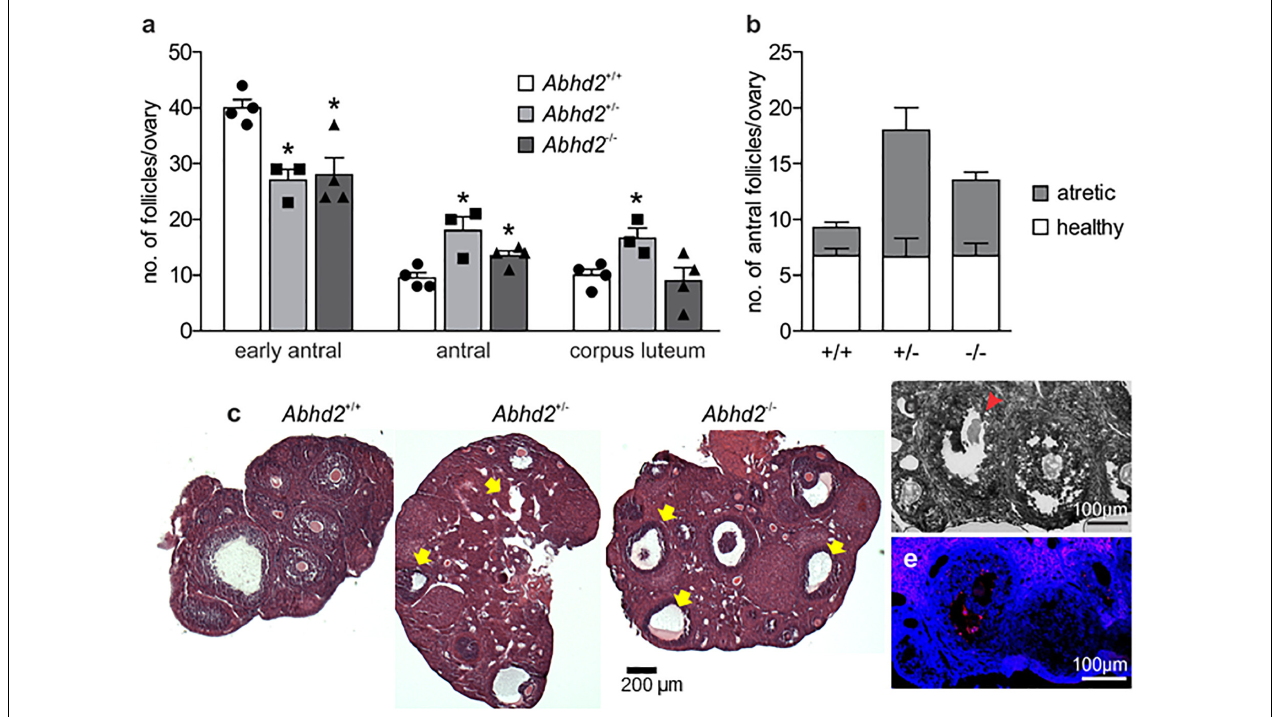
FIGURE 4 | Follicle count of the proestrus ovary. (a) Ovaries of 3.5-month-old Abhd2 + / − ( n = 3) and Abhd2 − / − ( n = 4) mice showed significantly lower numbers of early antral follicles, while the antral follicle number was increased compared with the Abhd2 + / + females ( n = 4). (b) However, although hematoxylin staining of Abhd2 + / − and Abhd2 − / − ovaries displayed a higher number of atretic antral follicles compared with the wild-type ovaries, the total number of healthy follicles was similar between genotypes. (c) Representative images of Abhd2 + / + , Abhd2 + / − , and Abhd2 − / − ovaries with apoptotic antral follicles marked by arrows. (d,e) TUNEL staining confirmed the follicles as apoptotic by labeling the granulosa cells of the atretic follicles. Statistical significance was calculated using the unpaired t -test and the significance of changes is indicated as follows: * p ≤ 0.05. Abhd2 + / + n = 4, Abhd2 + / − n = 3, and Abhd2 − / − n = 4, for all